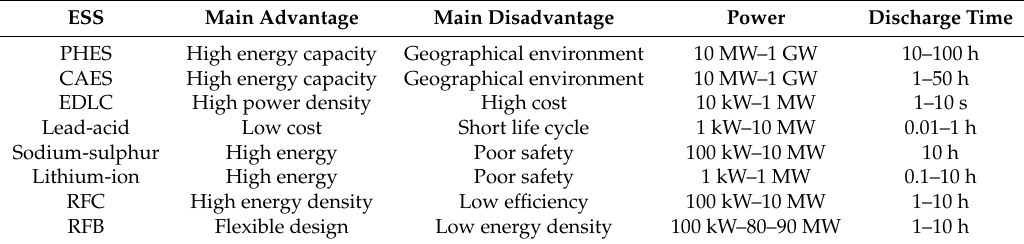
Table 1. Advantages, disadvantages, power and discharge time of main ESS. Extracted from